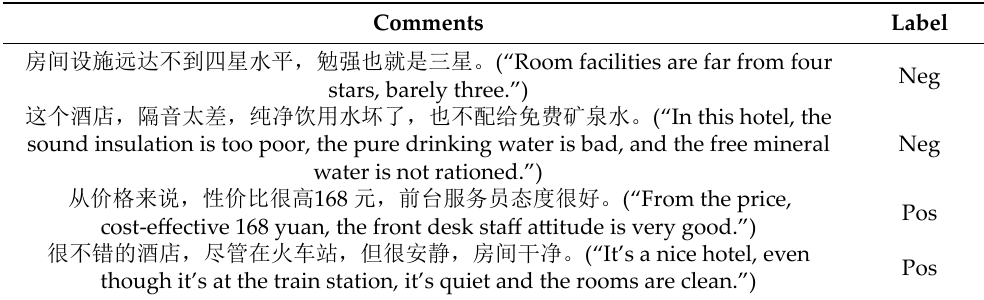
Table 3. Example